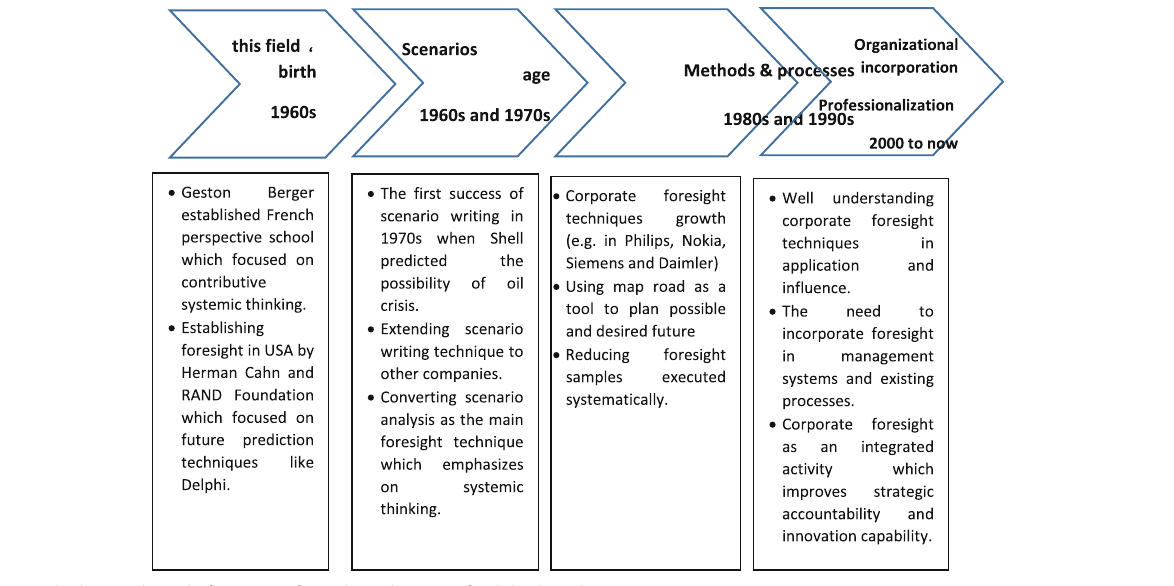
Fig. 1 The historical trend of corporate foresight in the view of Rohrbeck et al.